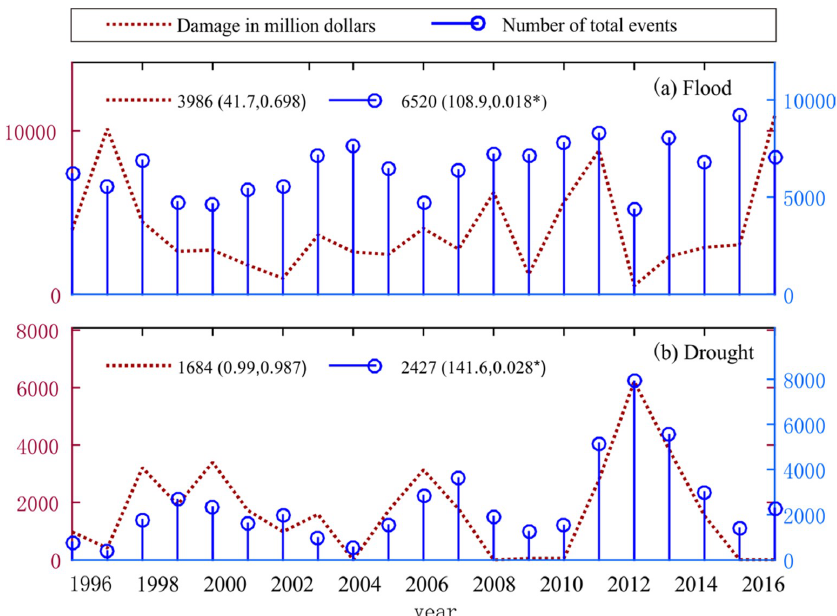
Figure 1. Changes in annual damages (red dotted line) and total occurrences (blue solid line) of ( a ) floods and ( b ) droughts during 1996–2016. The numbers out the brackets indicate the long-term annual mean values. The two numbers in the brackets are the changing trends and associated p values, respectively. The changing trends that are statistically significant at the 90% confidence level are highlighted with asterisks (*).